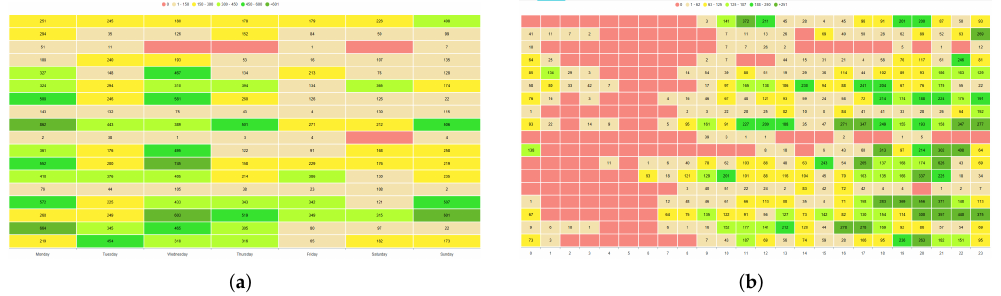
Figure 14. Online access heatmaps. ( a ) By weekday. ( b ) By hour.